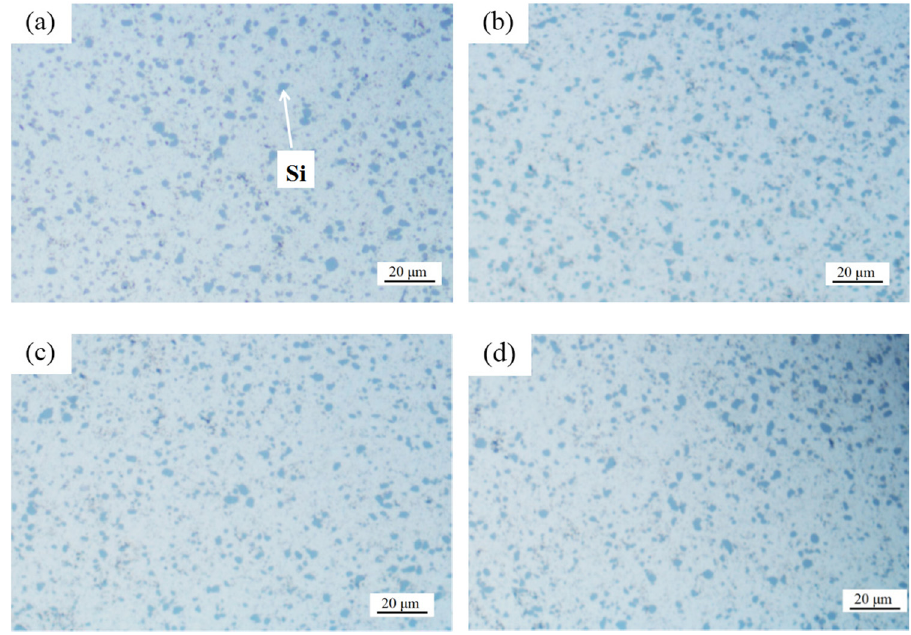
Figure 1: Metallographic structure of composites with di ff erent nano - SiCp volume fraction: ( a ) 1% SiCp, ( b ) 2% SiCp, ( c ) 3% SiCp, and ( d ) 4%